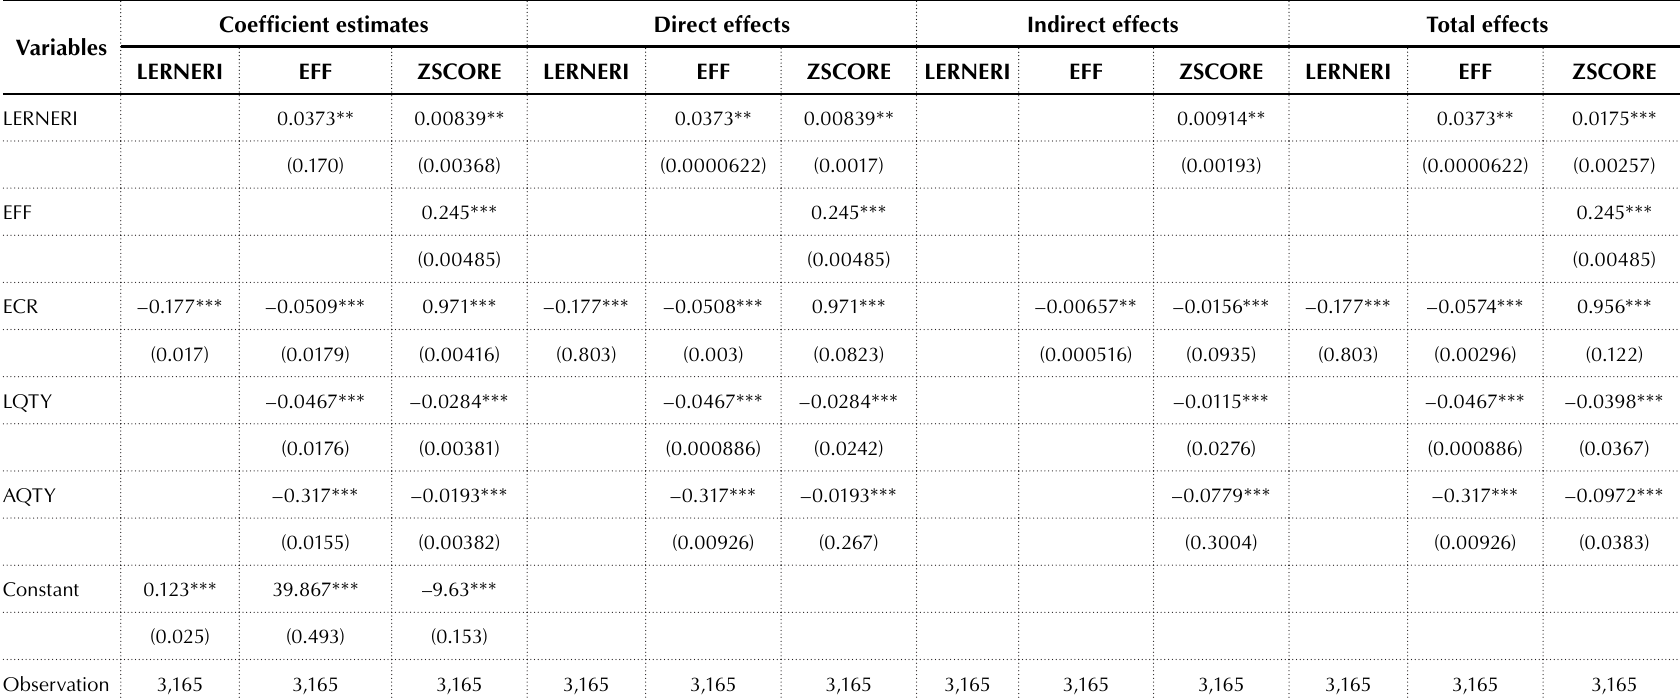
Table 2. Recursive model